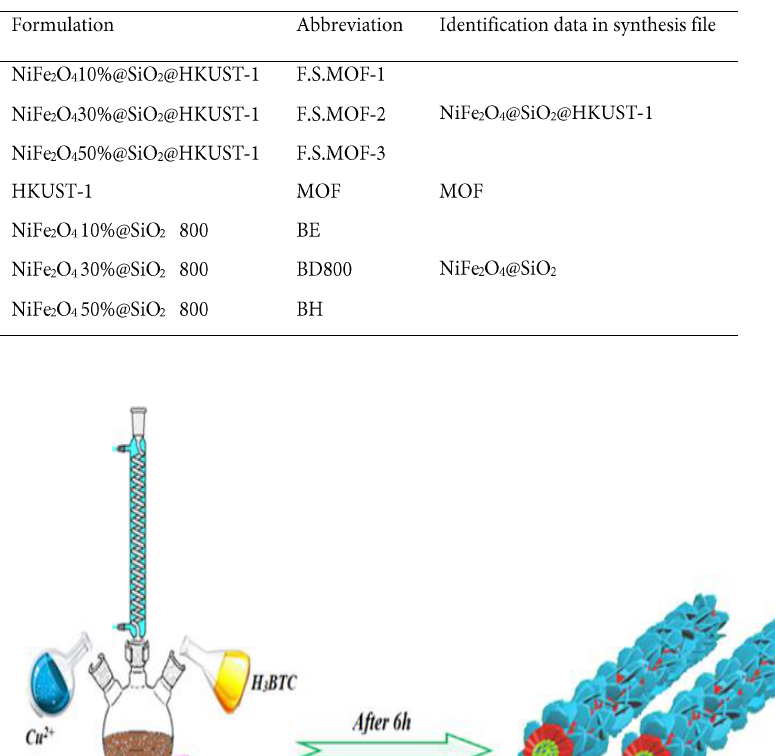
Table 1: Introducing sample